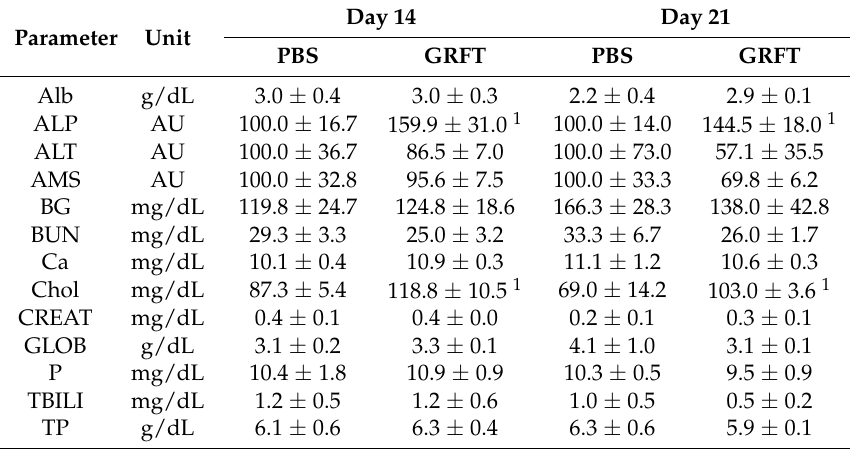
Figure 5. Effect of chronic GRFT treatment on spleen tissue and cell activation. ( A – C ) hematoxylin and eosin (H and E) stained spleens showing no, to minor, changes in spleen histology after 14 daily treatments with GRFT at 10 mg/kg. ( A , B ) are representative spleen specimens from the GRFT group at treatment end (Day 14) and Day 21 (14 days of treatment followed by a week of recovery), respectively; ( C ) representative spleen specimen from the PBS group at Day 14; flow cytometry was carried out after dual fluorescent staining with FITC-conjugated anti-CD4 or CD19 mAb in combination with PE-conjugated anti-B220 ( D ) or anti-CD69 ( E ). Relative amounts of splenocytes expressing a given surface marker were obtained with the PBS group value set at 100. B220+, cells staining positive for B220 only (single positive); total B220+ represent B220 single positive and B220/CD19 double positive (*, p < 0.05; **, p < 0.01). Table 1. Effect of 14 daily s.c. doses of 10 mg/kg GRFT on blood chemistry